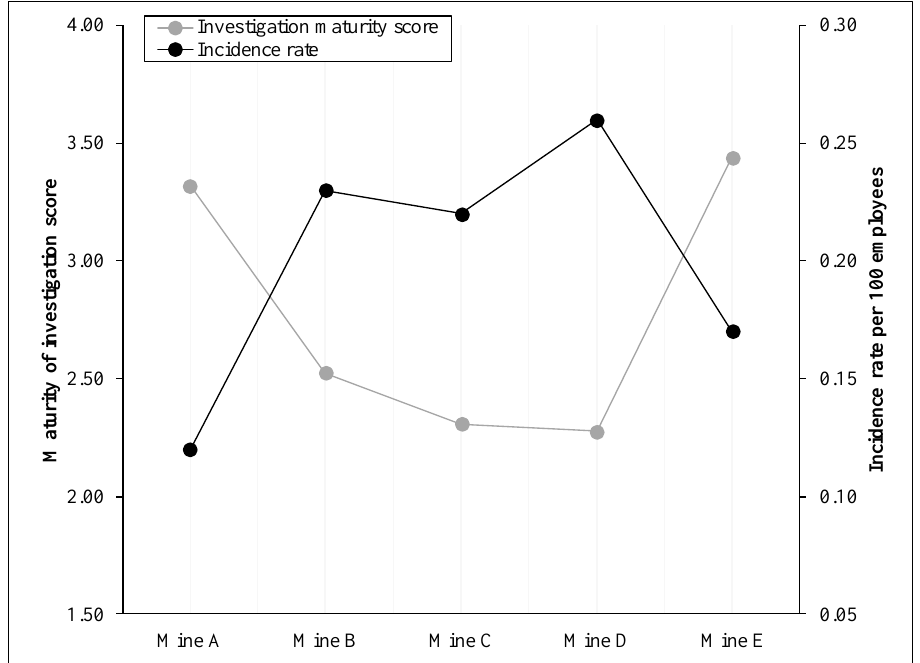
Figure 4. A plot of incidence rates and maturity of investigation scores of the mines.